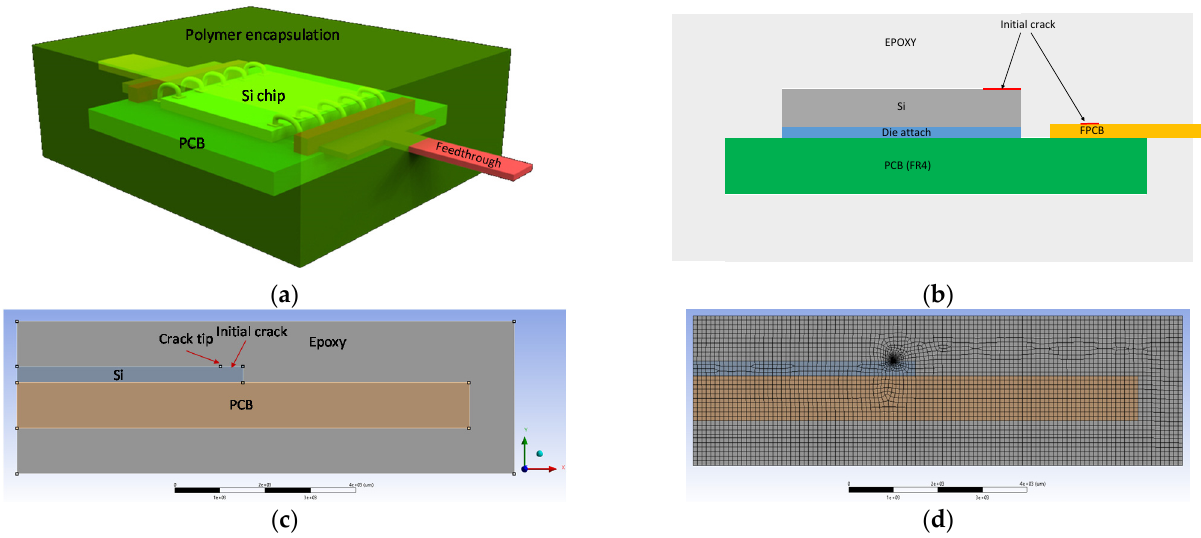
Figure 5. Finite element method (FEM) model of the biocompatible package. ( a ) Concept; ( b ) Cross-sectional view; ( c ) 2D model; ( d ) Meshed model. Table 3. Material properties and model